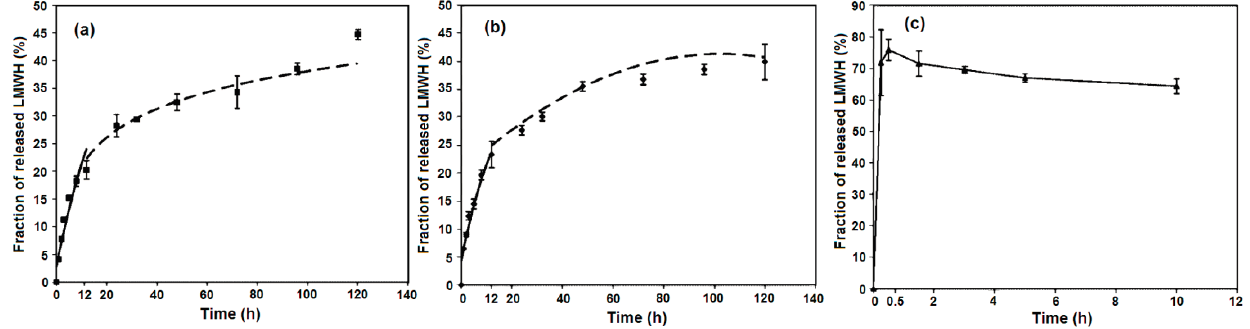
Figure 6. In vitro Low molecular weight heparin (LMWH) release curves from ( a ) LMWH20–LDH; ( b ) LMWH100–LDH; ( c ) physically mixed powder of heparin sodium salt and Cl–LDH (1/8 weight ratio). In ( a ) and ( b ), the solid and dashed curves represent the predictions of the modified Freundlich and parabolic diffusion model, respectively. Reprinted with permission from [59] (Copyright 2008 American Chemical